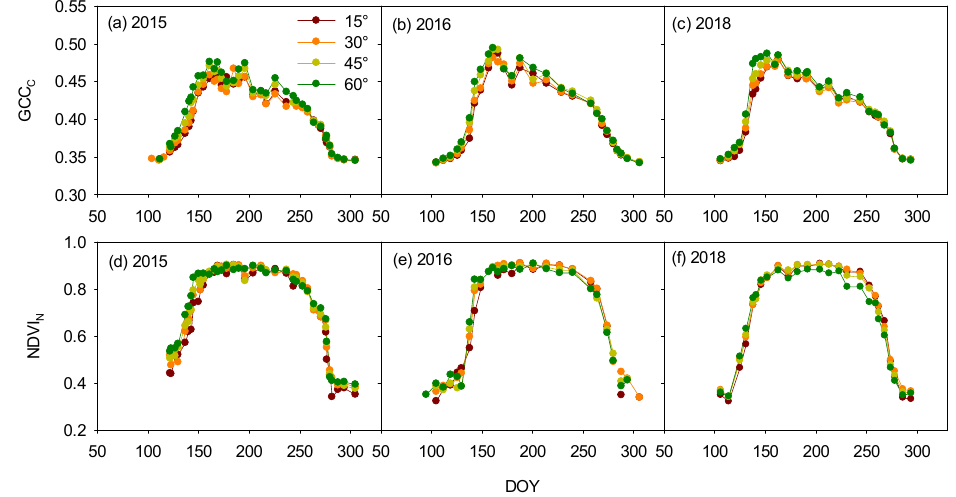
Figure 2. Seasonal variations in the green chromatic coordinate from camera (GCC C ) and the narrowband normalized difference vegetation index from spectroradiometer (NDVI N ) at different inclination-angles for the north direction in 2015 ( a , d ), 2016 ( b , e ), and 2018 ( c , f ). DOY: day of year. Table 1. Spearman’s rank correlations of vegetation indices at different inclination-angles in the north direction.